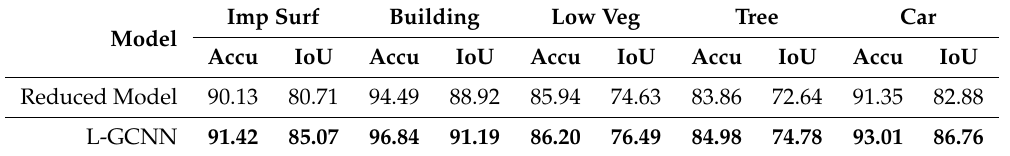
Table 6. Comparisons between reduced model and L-GCNN with segmentation accuracy and IoU scores (%). Note that here none of the augmented multiscale samples were employed for training.